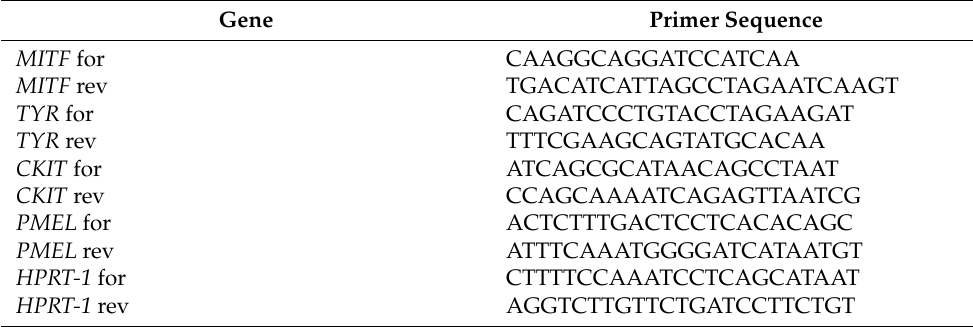
Table 3. Primer sequences used to detect MITF, TYR, CKIT and PMEL in eMORS.